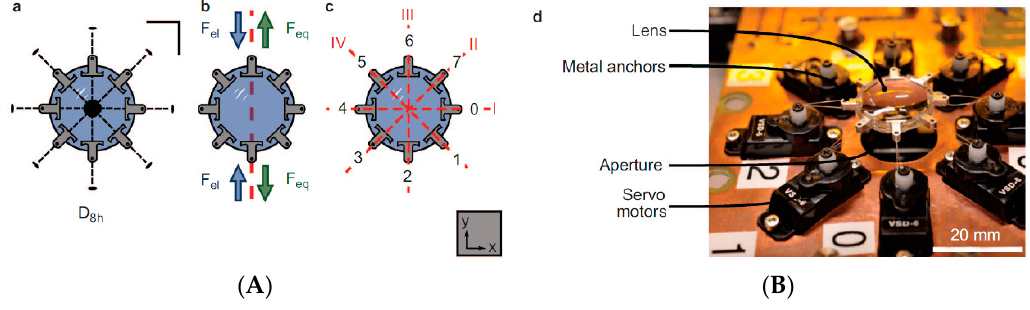
Figure 9. ( A ) ( a ) Schematic of elastomeric polymer anchored lens; ( b ) one of the actuation axes (in red dashed lines). F eq denotes the applied radial force required to change the curvature of the lens while F el represents the restoring force due to polymeric lens material. ( c ) Labeling of the four actuation axis. ( B ) Picture of the anchored lens with servo motors. Reprinted by permission from Macmillan